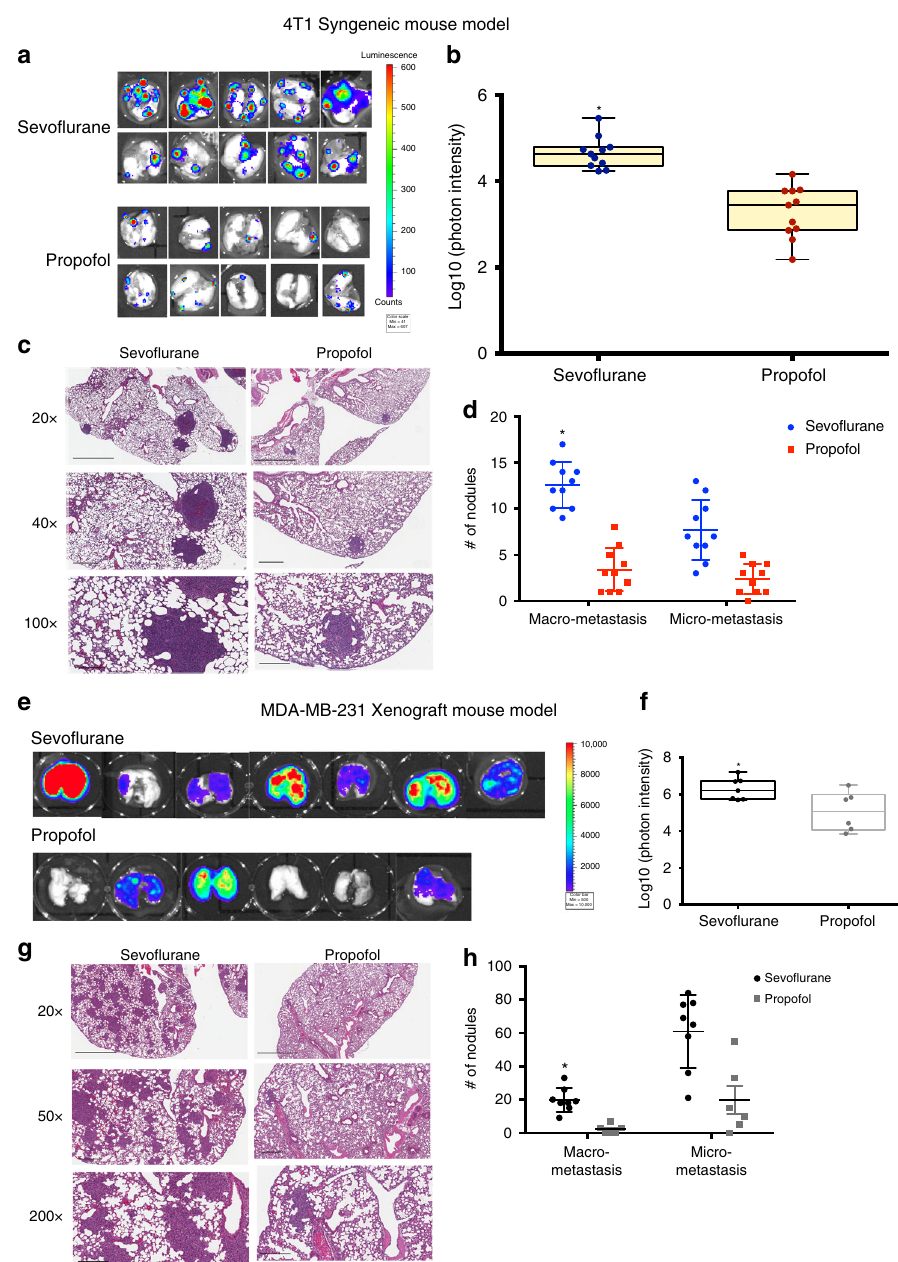
Fig. 1 Mice underwent mastectomy with sevo fl urane developed more lung metastasis than with propofol. Mice bearing primary tumors were generated by orthotopically implanted with the luciferase-tagged murine 4T1 breast cancer cells or human MDA-MB-231 breast cancer cells in the mammary fat pads in balb/c mice or NOD-SCID mice respectively. Surgical dissection of primary tumor with sevo fl urane signi fi cantly increased lung metastasis than with propofol in both models. Mastectomy was performed in mice models and lung metastasis were evaluated two weeks after surgery. In the 4T1 model, a ex vivo lung bioluminescent imaging and b photon intensity of them showed remarkably more lung metastasis in the mice received sevo fl urane than those received propofol ( n = 10 for each group, p = 0.013, unpaired t-test). Center line of box plot represents the median, bounds represent the fi rst and third quantiles, and whiskers represent the lowest and highest value. The result of bioluminescent imaging was con fi rmed by ( c ) histology (H&E staining) pictures of the lung sections from each group at different magni fi cations. The macro-metastatic nodules versus micro-metastatic nodules in each group were quanti fi ed. d The examination of number and size of metastatic nodules showed that signi fi cantly more macro-metastases were observed in sevo fl urane group than in propofol group ( n = 10, p = 0.019 for macro-metastasis, two-way ANOVA + Dunnett ’ s post hoc tests). The results in 4T1 syngeneic model were observed in the MDA-MB-231 xenograft model as shown in ( e ) bioluminescent images of lung area of mice, f quantitative measurements of the ex vivo lung photon intensity ( p = 0.04, n = 8 for sevo fl urane group and n = 6 for propofol group, unpaired t -test), g histology of the lungs and h quanti fi cation of metastatic nodules ( n = 8 for sevo fl urane group and n = 6 for propofol group, p = 0.016 for macro-metastasis, two-way ANOVA + Dunnett ’ s post hoc tests). Data are shown as mean ± S.D. Scale bar: 20× = 2 mm, 40× = 600 μ m, 100× = 300 μ m. Source data are provided as a Source Data fi